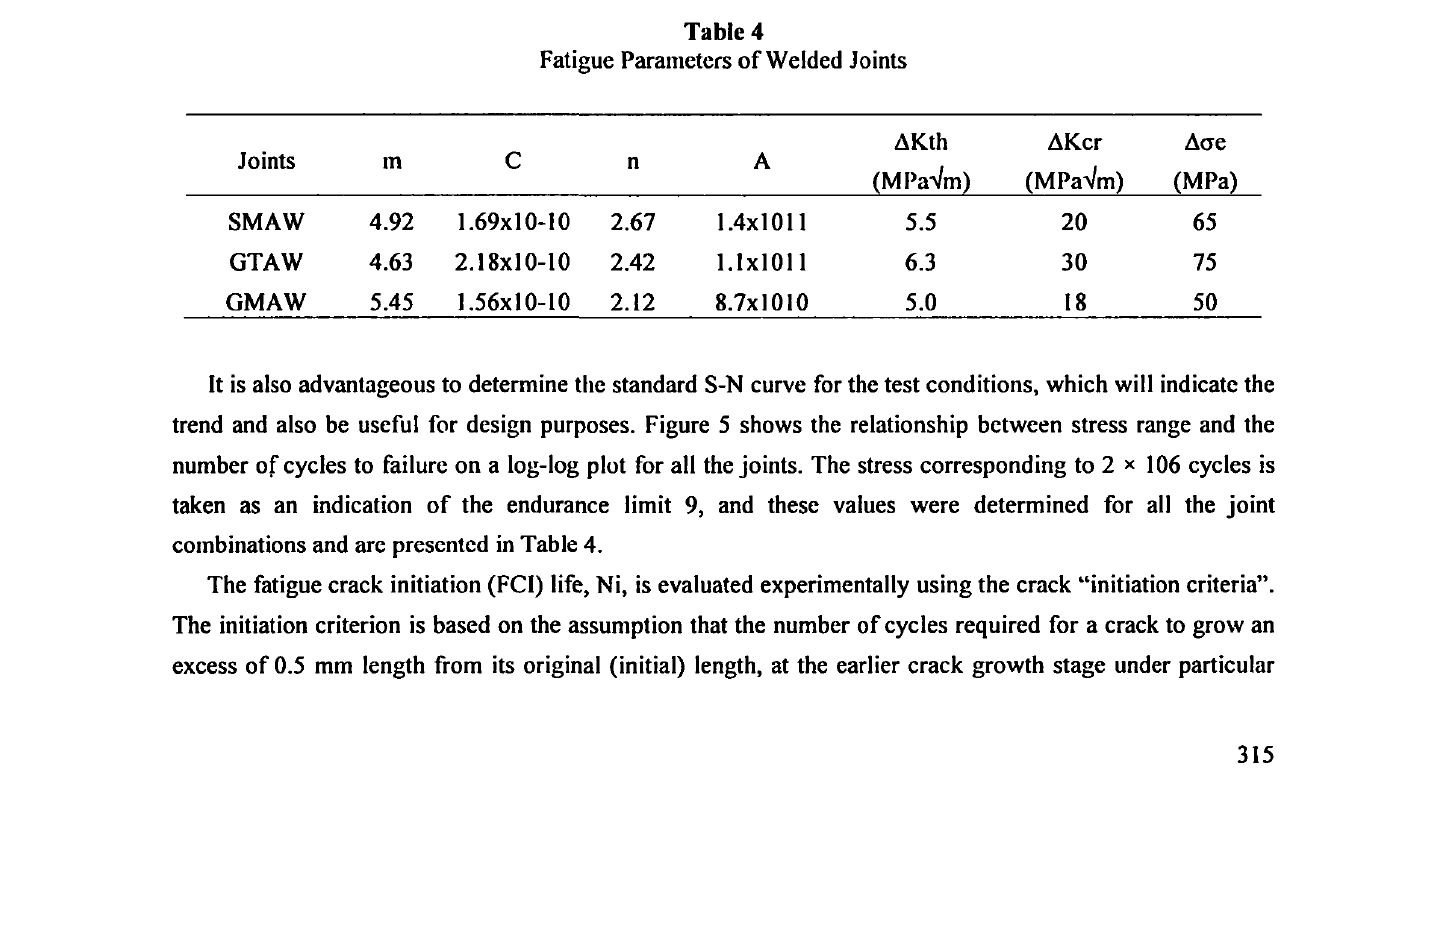
Fig. 4: Relationship between FCGR and SIF